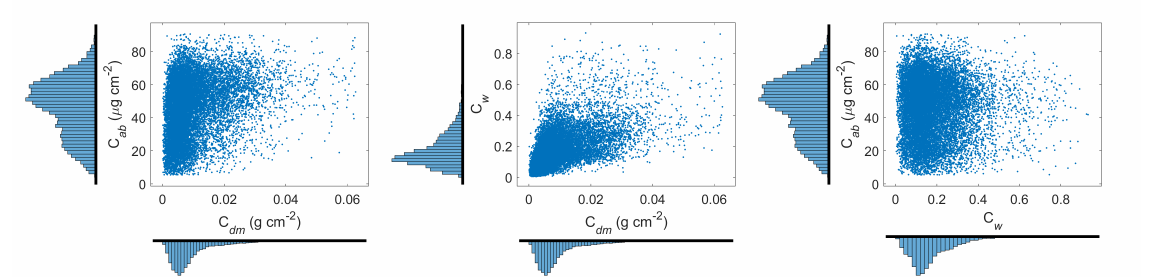
Figure 2. Constrained random samples of leaf chlorophyll (C ab ), leaf dry matter (C dm ), and leaf water (C w ) contents based upon prior knowledge of the TRY database, the MODIS land cover (MCD12Q1), kernel density estimators, and